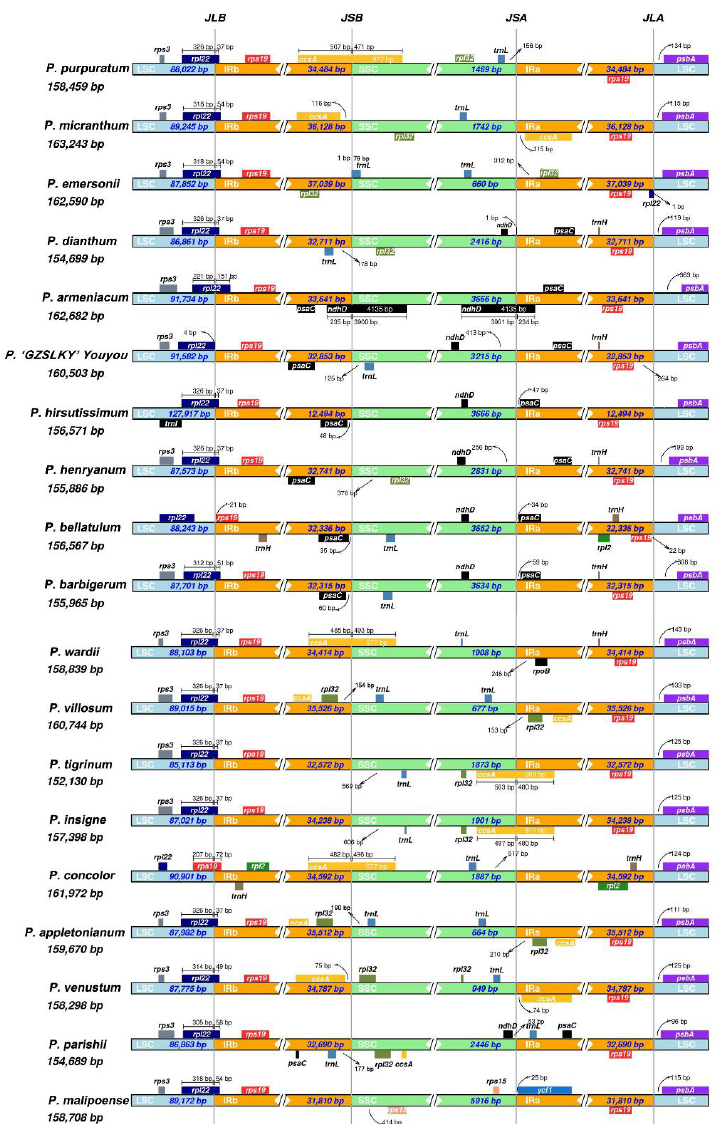
Figure 2. Comparison of the borders of the LSC, SSC, and IR regions between 19 chloroplast genomes. JLB, JSB, JSA, and JLA denoted the junction sites of LSC/IRb, IRb/SSC, SSC/Ira, and IRa/LSC, respectively.